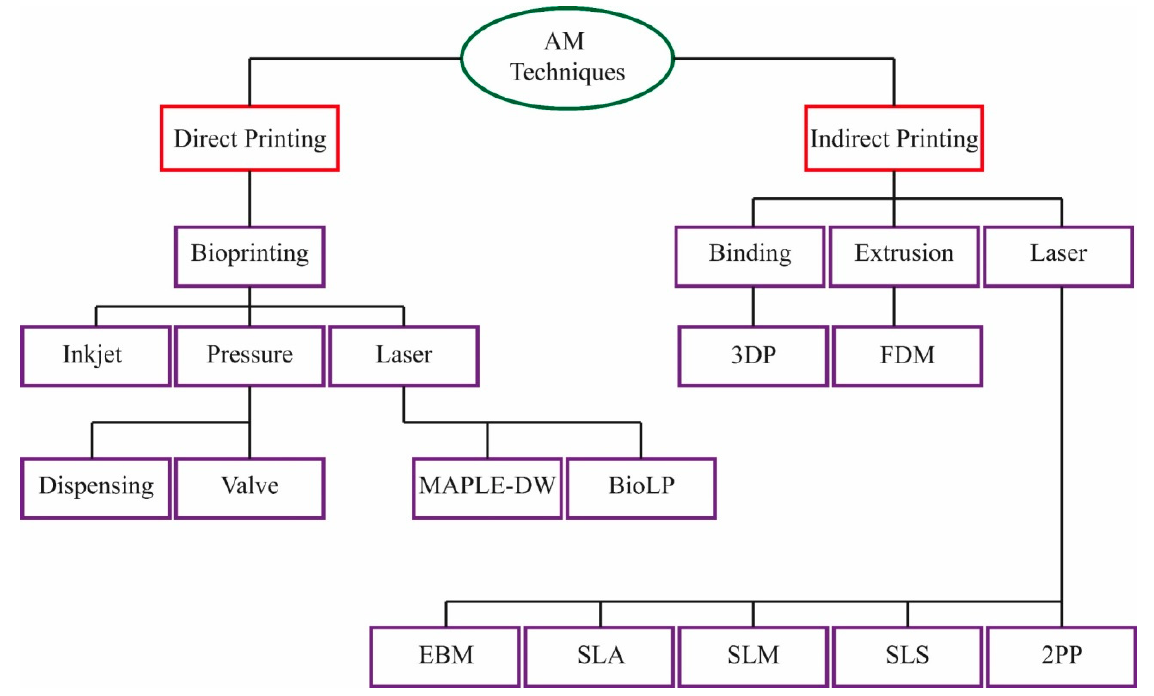
Figure 6. A review of additive manufacturing (AM) technologies and related subsessions [38].